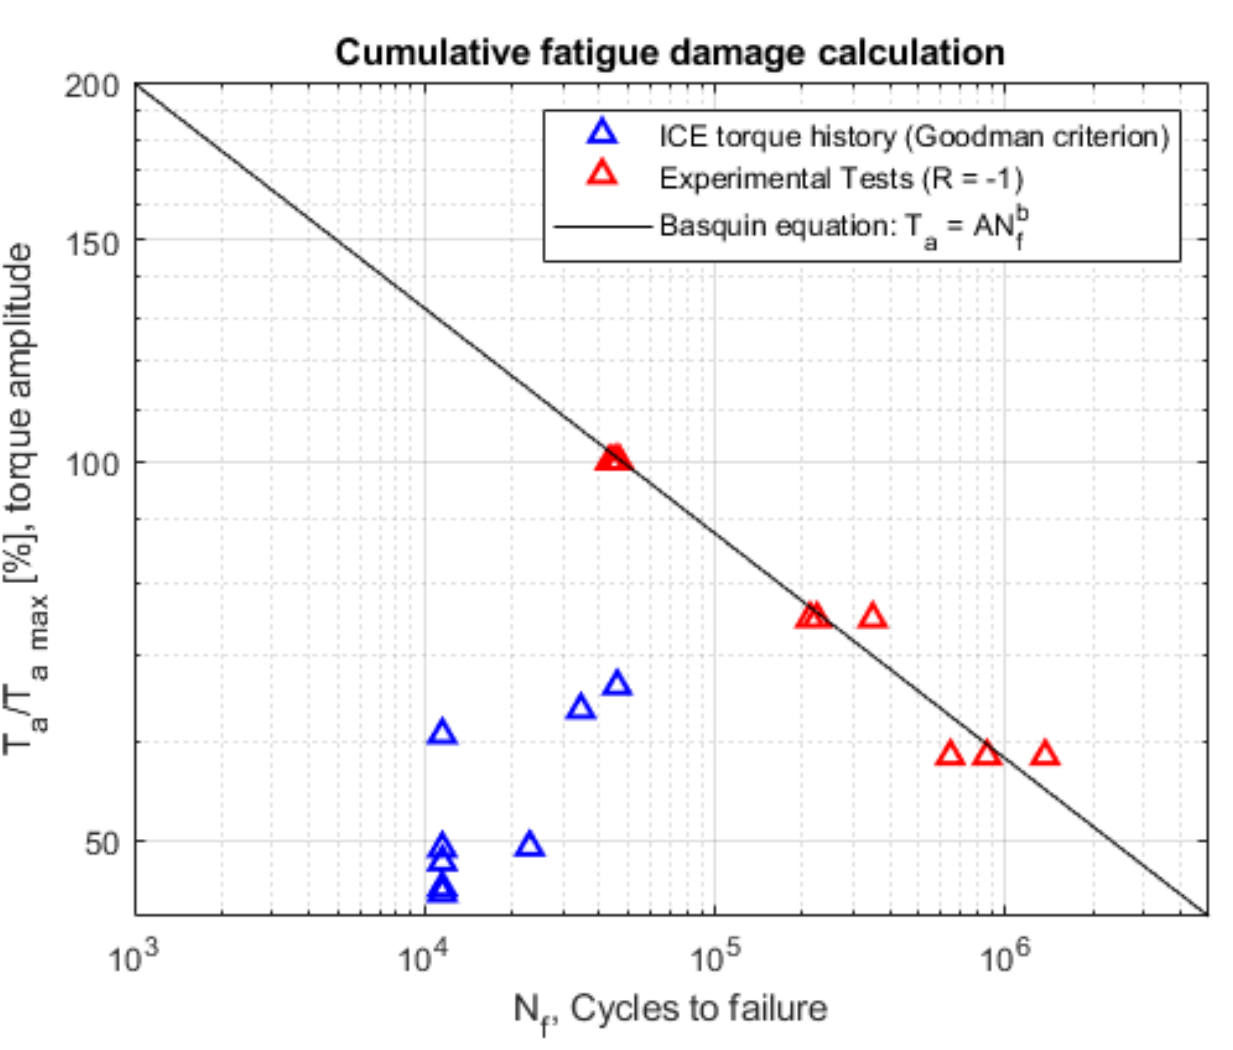
Figure 18. ICE vehicle model torque history referred to R = − 1 through the Goodman criterion. Table 7 shows the values of T a T a max , working cycles 𝑁 and the corresponding failure cycles N f . Table 7. Torque amplitude, working cycles and failure cycles for the ICE vehicle model.